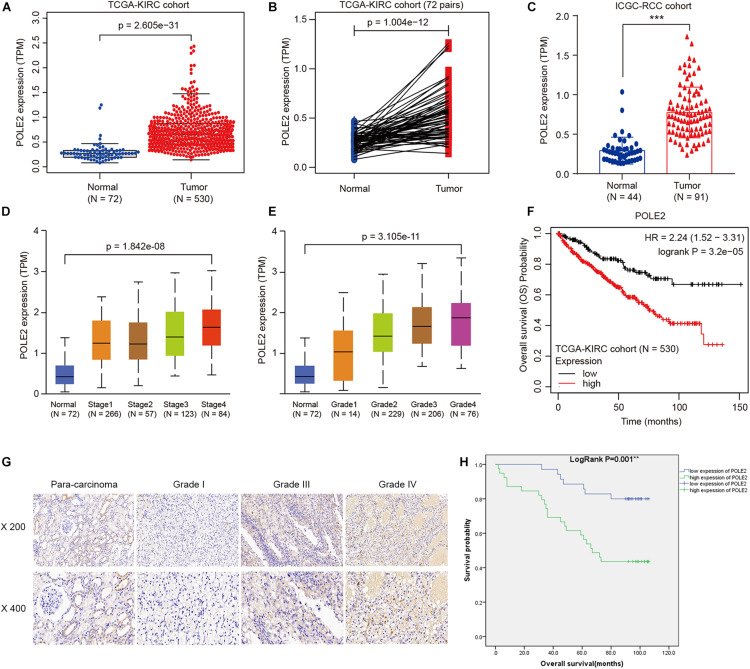
POLE2 level is upregulated and associated with various clinicopathological parameters in RCC. The POLE2 mRNA level in RCC was obtained from The Cancer Genome Atlas Kidney Clear Cell Carcinoma dataset (TCGA-KIRC; containing 72 normal tissues and 530 RCC tissues) and International Cancer Genome Consortium (ICGC; containing 44 normal tissues and 91 RCC tissues). The POLE2 mRNA levels were compared in different clinicopathological parameters: (A,C) Cancer vs. para-cancer, (B) Carcinoma vs. paired para-cancer, (D) TNM stage, and (E) G stage. (F) Kaplan-Meier curves of the overall survival of RCC patients with high or low POLE2 expression in TCGA-KIRC cohort. (G) Representative immunohistochemical staining for POLE2 in RCC and adjacent normal tissues. (H) Kaplan-Meier curves of the overall survival of RCC patients with high or low POLE2 expression. **P < 0.01, ***P < 0.001.